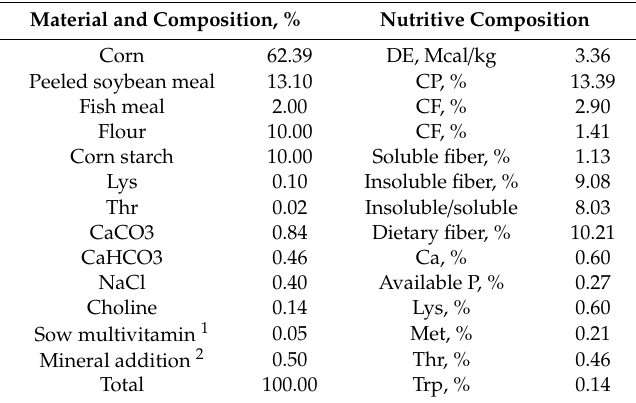
Table 2. Control group diet and nutritive